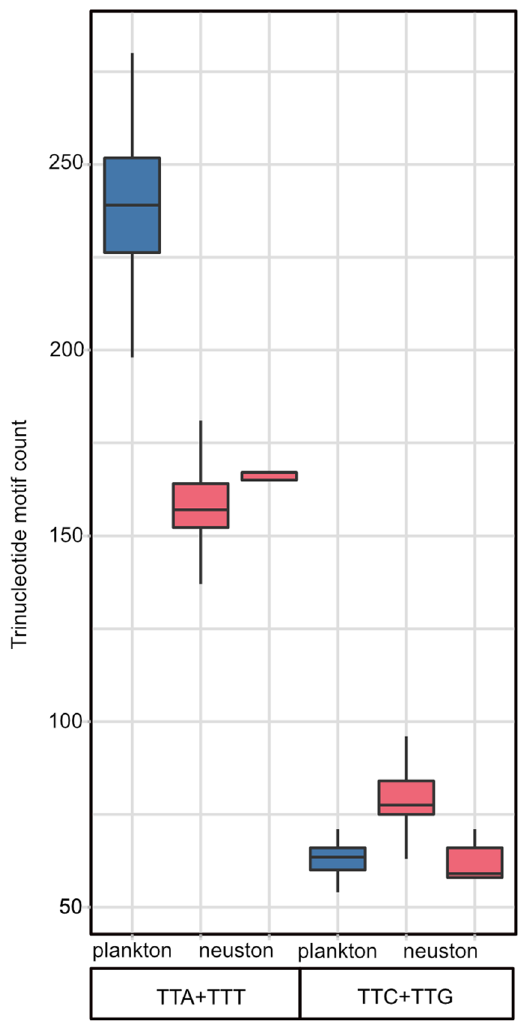
Figure 7. Box and whiskers plots comparing counts of trinucleotide motifs in cladoceran crustacean DNA sequences from the rRNA gene region of mitochondrial genomes. The motifs from the plus and negative strands were summed to attain the final counts. The motifs on the left (TTA/TTT) have been shown to promote UV radiation (UVR) photolesion formation while those on the right (TTC/TTG) are noted for lacking photolesion formation. Box plots are colored by habitat with the blue boxes representing planktonic daphniids and moinids (low UVR habitat, N = 22); and pink boxes (high UVR neustonic habitats) representing sequences from specimens of Scapholeberis (N = 358; left) and Megafenestra (N = 13; right). Sequence and specimen details are available in the Supplementary